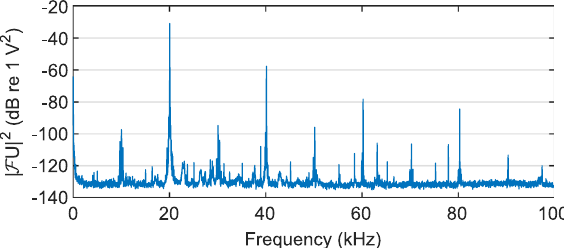
Figure 6. Square of the absolute value of the discrete Fourier transform of the signal j F U j 2 of a single channel in the frequency range from 0 kHz to 100 kHz with a frequency resolution of 15.625 Hz time-averaged over 0.64 s. For this measurement, the ultrasonic welding machine was operated in the continuous mode.